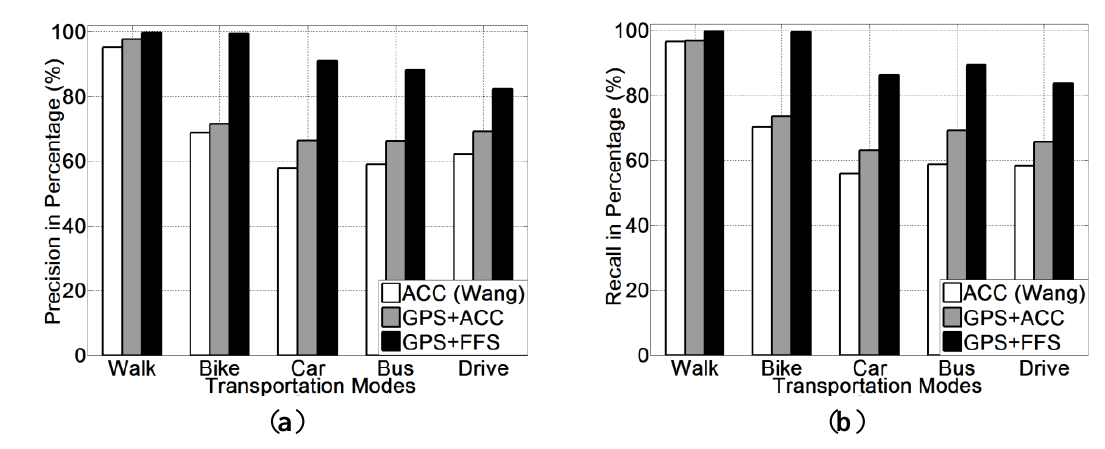
Figure 10. Transportation mode recognition results using decision tree: ( a ) precision; ( b ) recall.